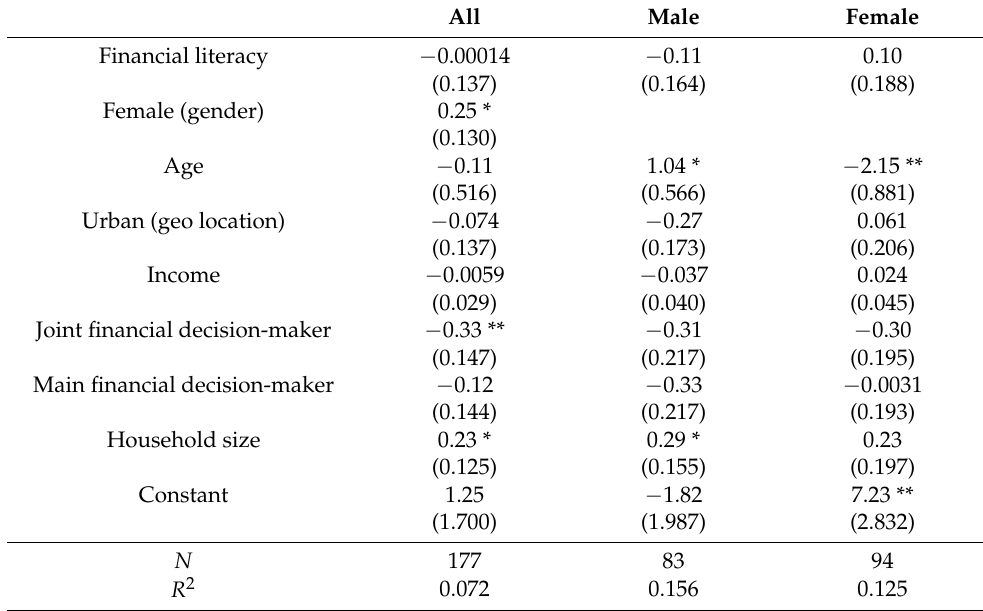
Table 4. OLS Regression: dependent variable perceived financial risk PWTFR.